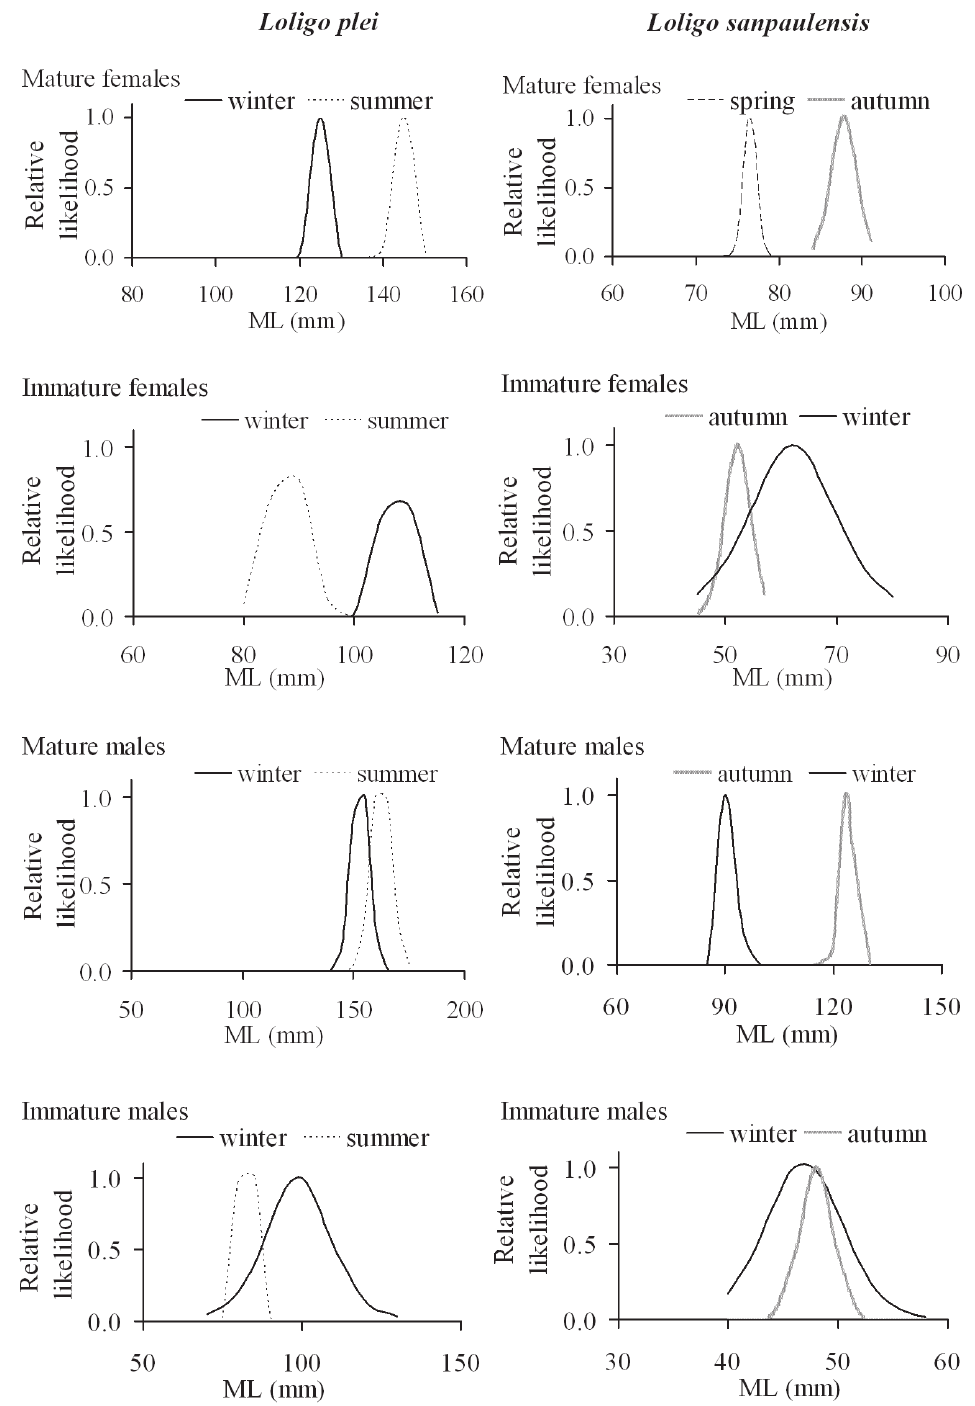
Fig. 2 . – Likelihood profiles showing seasonal differences in mean mantle length (mm) for mature and immature males and females of L. plei and L. sanpaulensis